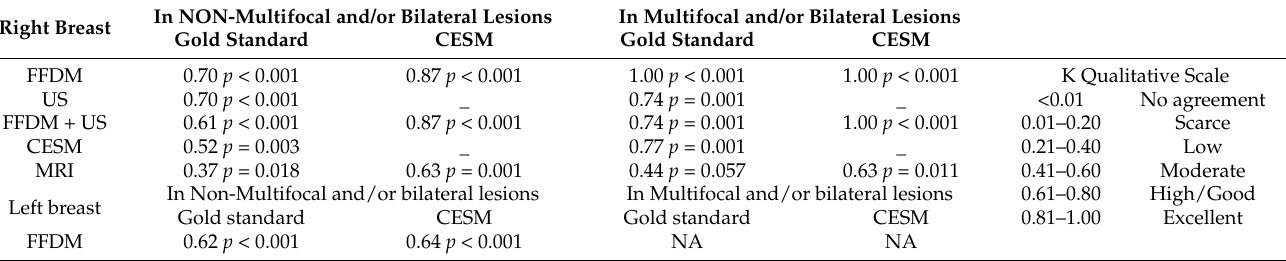
Table 5. Concordance analysis between imaging techniques. Per patient approach ( N : 118). In NON-Multifocal and/or Bilateral Lesions In Multifocal and/or Bilateral Lesions Right Breast Gold